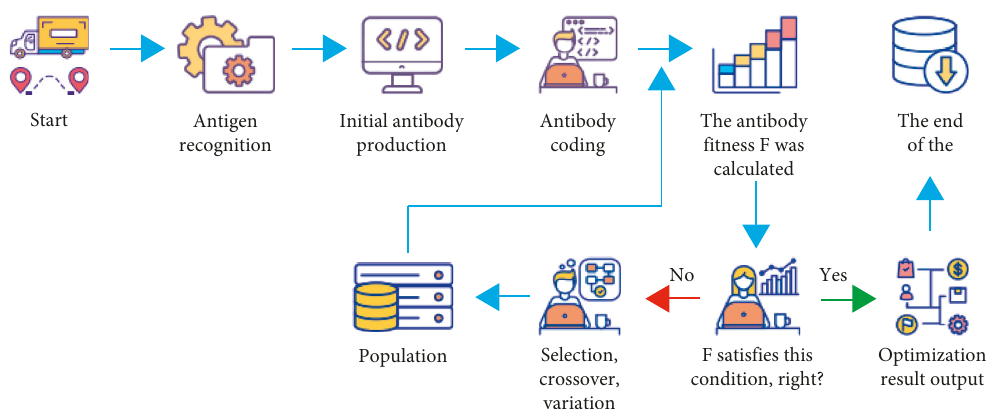
Figure 1: Flowchart of genetic